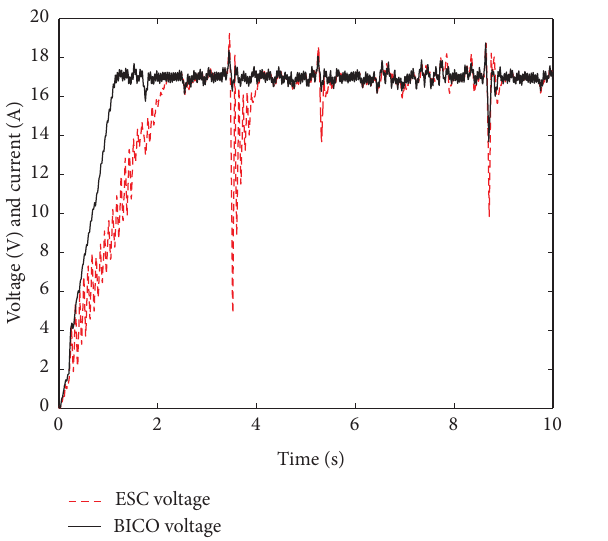
Figure 14: Voltage tracking of BICO MPPT and ESC MPPT in the presence of a white noise with noise power 0.04 .